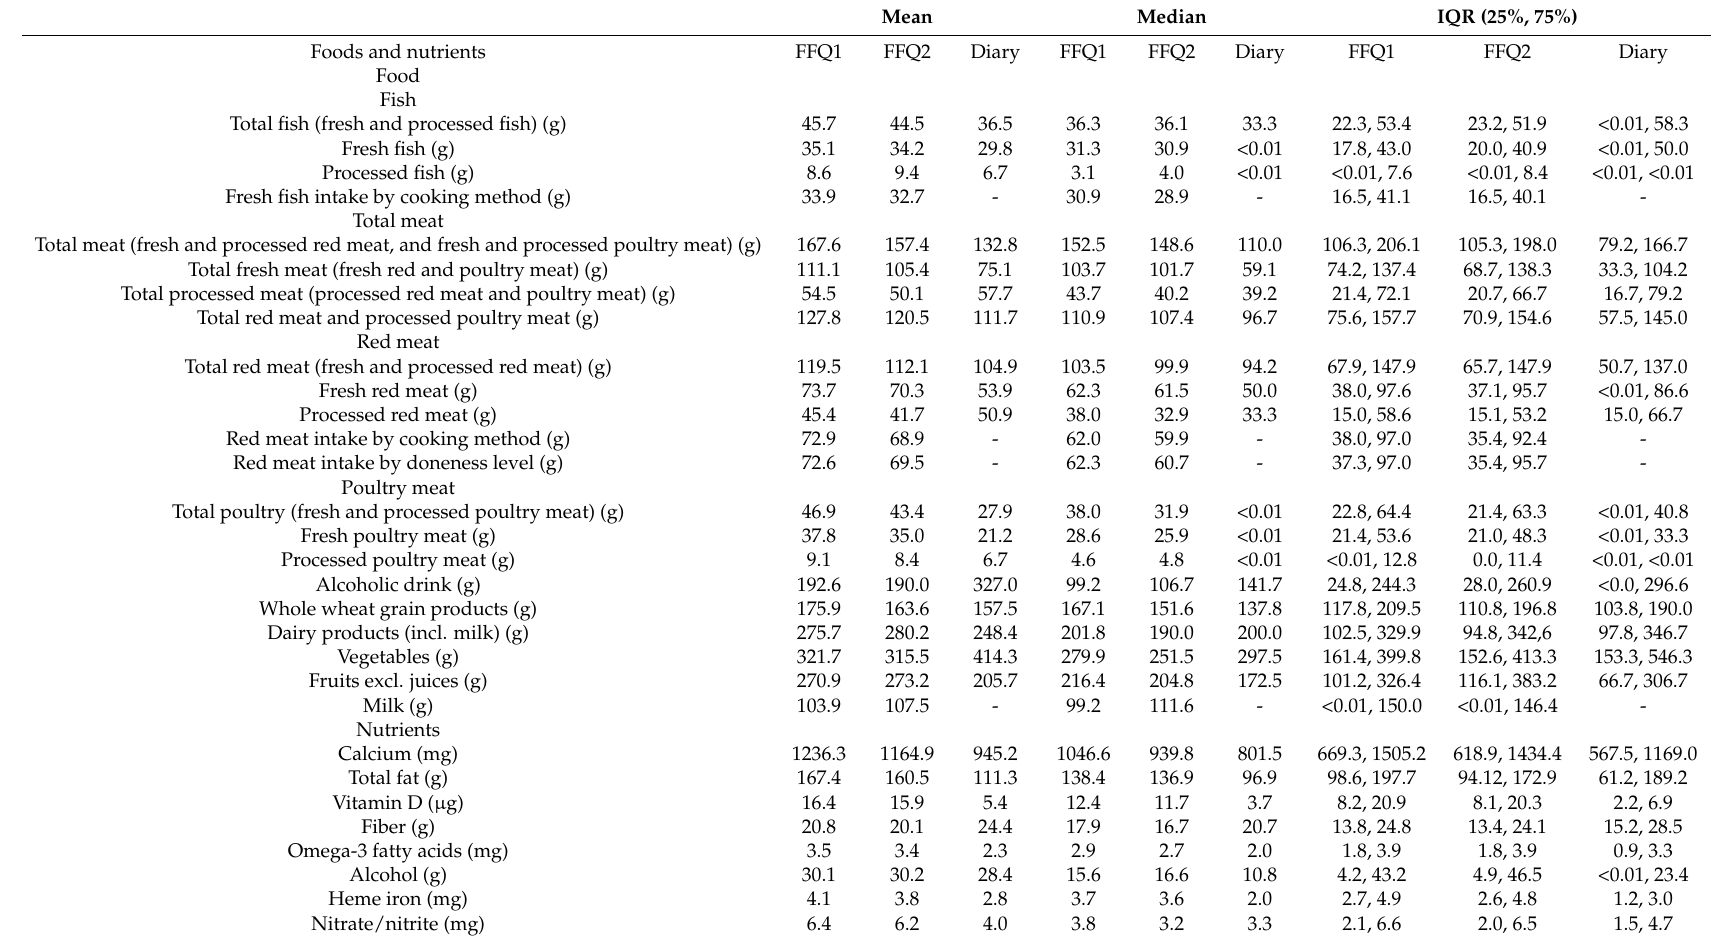
Table 2. Descriptive statistics (mean, median, and IQR) for reproducibility ( n = 162) and validity ( n = 156)